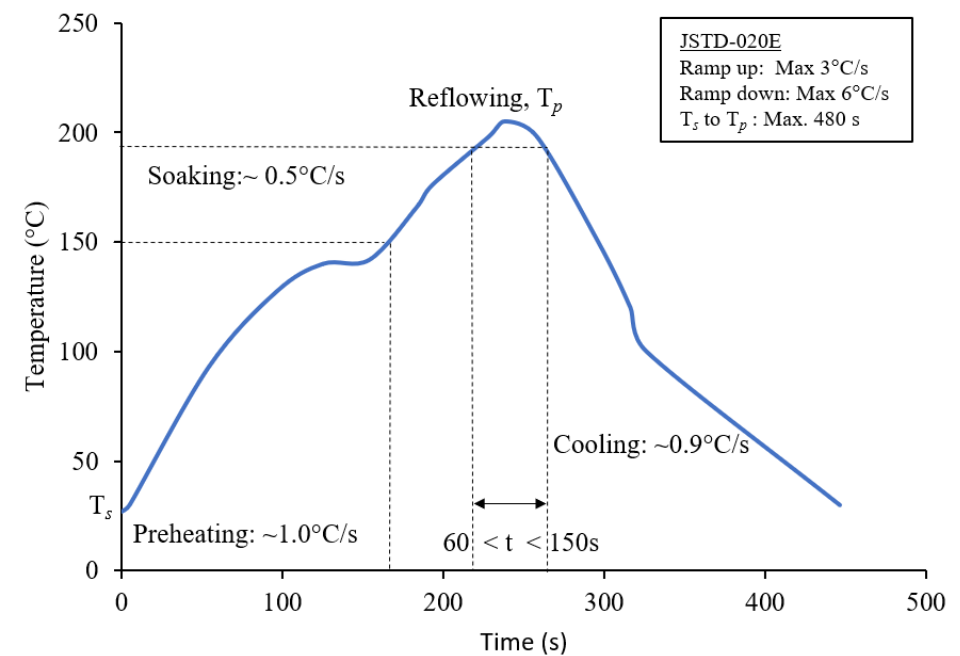
Figure 5. Thermal profile setting in the reflow oven.